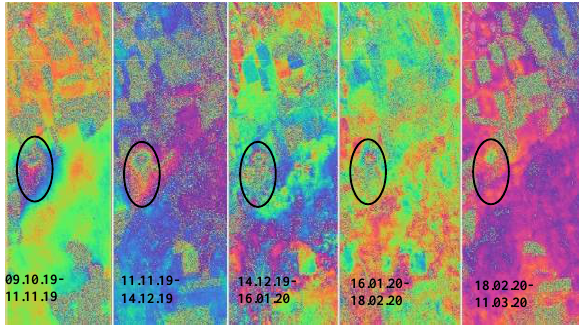
Figure 6. Sequential analysis of interferograms (PAZ satellite image © Hisdesat Servicios Estratégicos S.A.,